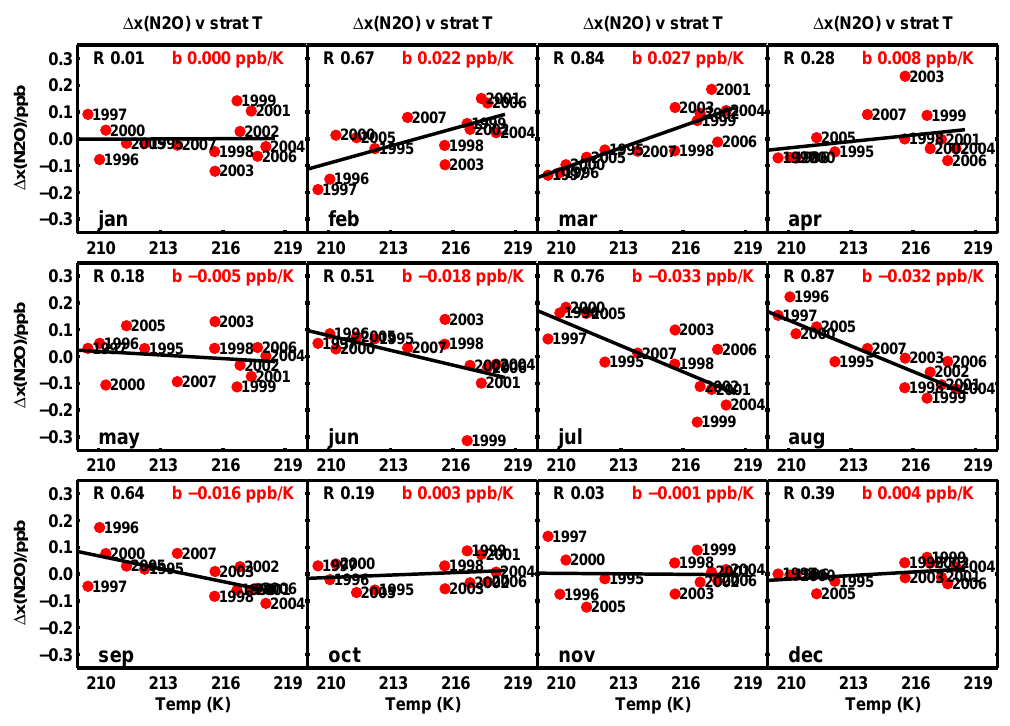
Fig. 5. Detrended AGAGE N 2 O data at Mace Head, Ireland (from Fig. 1a), sorted by month and plotted vs. mean polar (60–90 ◦ N) winter (January–March) lower stratospheric (100hPa) temperature from NCEP reanalysis data. The mean of the detrended N 2 O data for each month is subtracted to permit all months to be plotted with the same y-axis scale. The Pearson’s correlation coefficient R and the slope b of each linear regression are